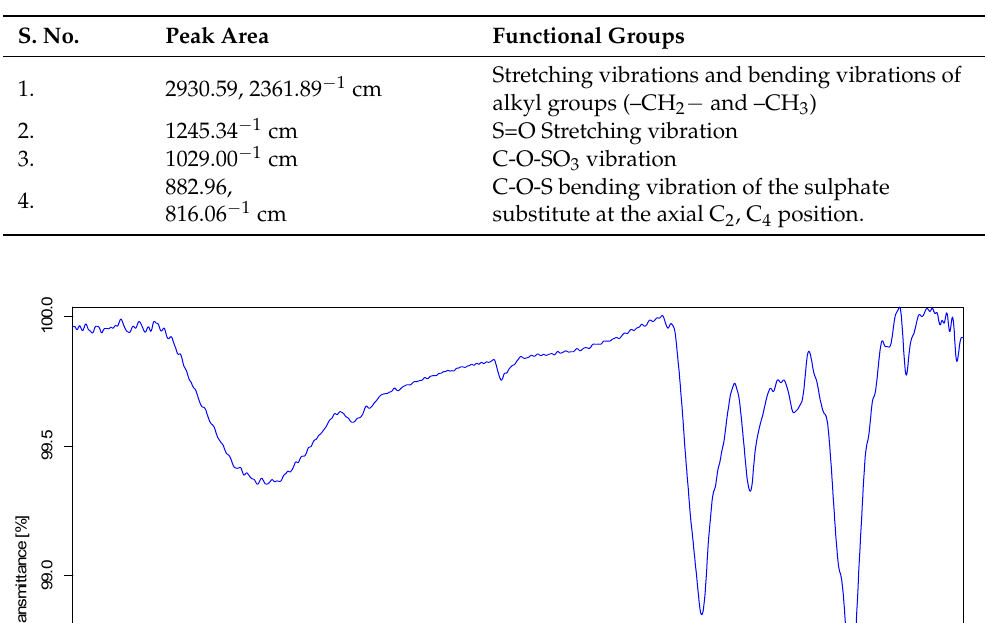
Table 3. The FT-IR analysis of S. ilicifolium .